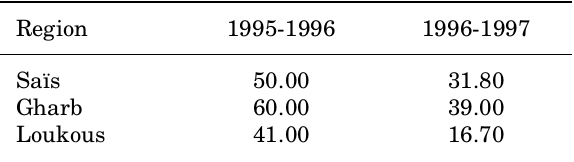
aged 38.98%, followed by Saïs with 31.80%. The field incidence remained very low in Loukous at 16.67%. In Saïs, developed downy mildew remains a matter for concern however because of high field incidences of 41.17% at Aïn Jemaa and 33.33% at Aïn Orma and Boufekrane (Table 2). At My Driss and Oued Rommane, on the other hand, the field incidence was only 16.66%. In Gharb, the highest field incidence was observed at Sidi Mohamed Lahmer and in the Mnasra area: 66.66% and 62.5% respectively (Table 2). In addition, this dis- ease was present in 44.44% of inspected fields at Souk Larbaa and in 45.45% of fields at Allal Tazi.